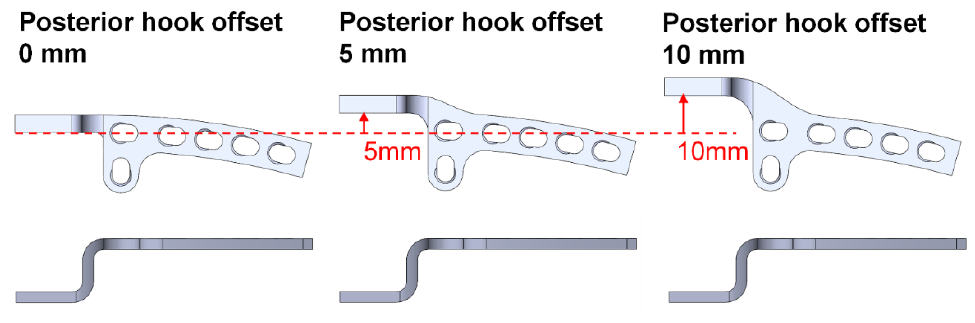
Figure 2. The posterior hook offsets were set at 0 mm, 5 mm, and 10 mm.